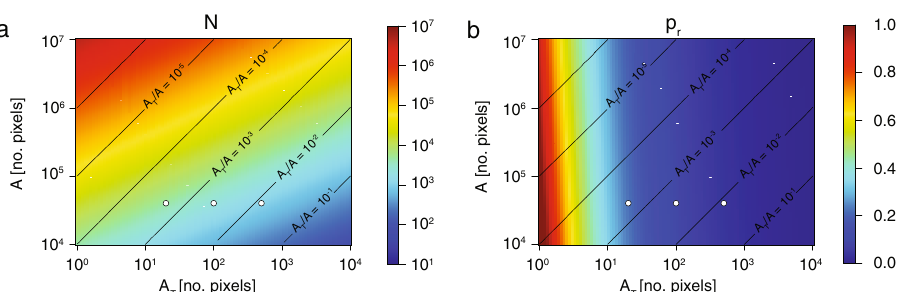
Fig. 2 Variation of N and p r as a function of observational scales for OCNs and real river networks. a Expected value of number of network nodes N as a function of threshold area A T and total drained area A (from Eq. (1)); the white dots indicate the values of A T and A used to generate the OCNs used in this analysis. b Expected value of branching ratio p r as a function of A T and A (from Eq. (1)); symbols as in a .